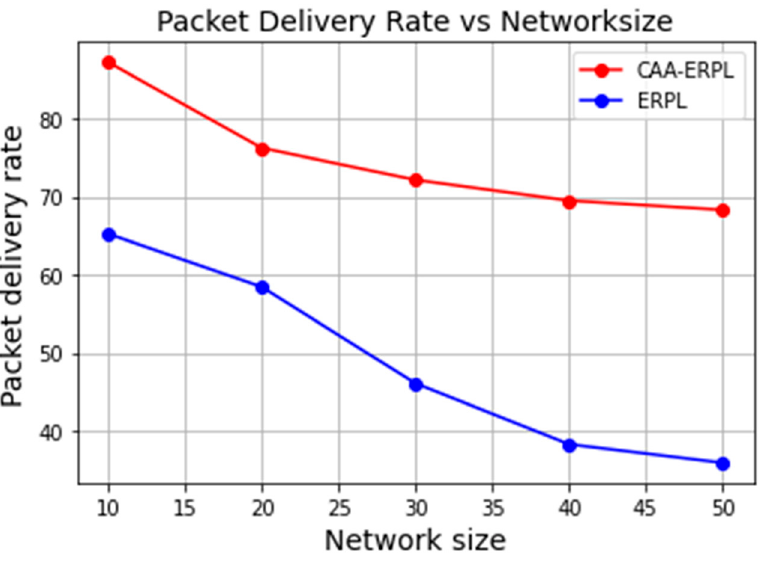
Figure 7. PDR vs. Figure 7. PDR vs. scalability.